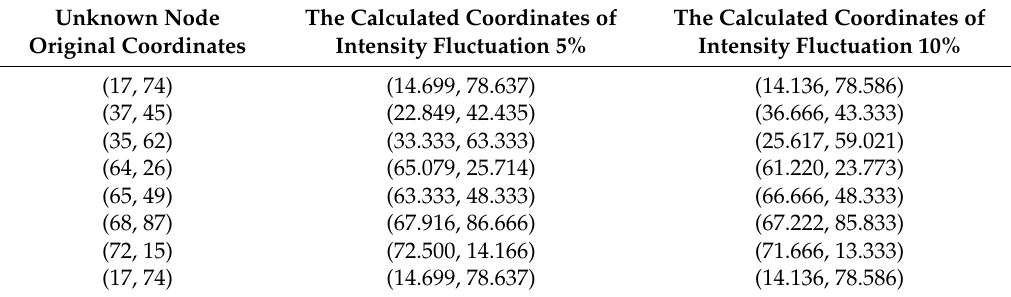
Table 7. Localization results ( n = 32).